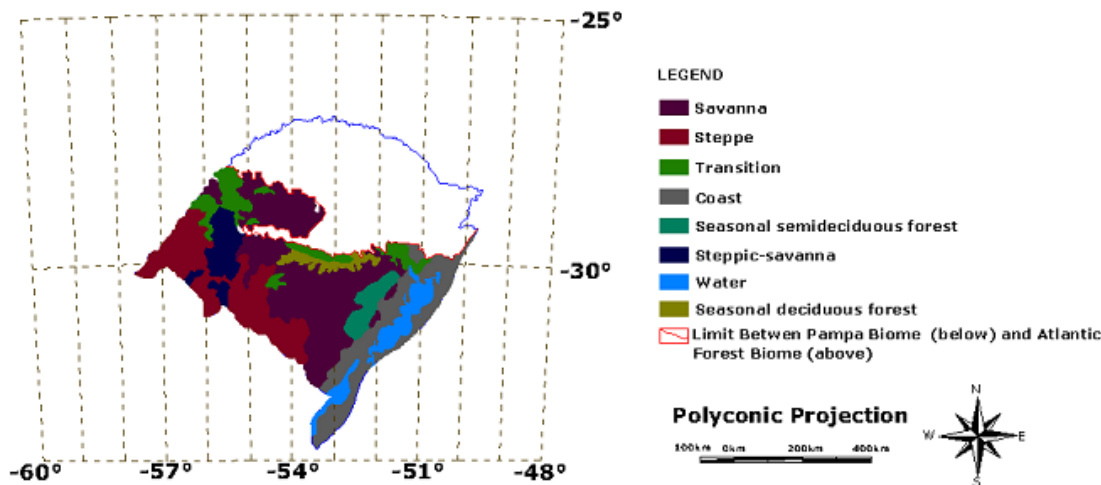
Figure 3. Physiographic regions of the Pampa biome, based on the distribution of trees. Adapted from UFSM/SEMA-RS